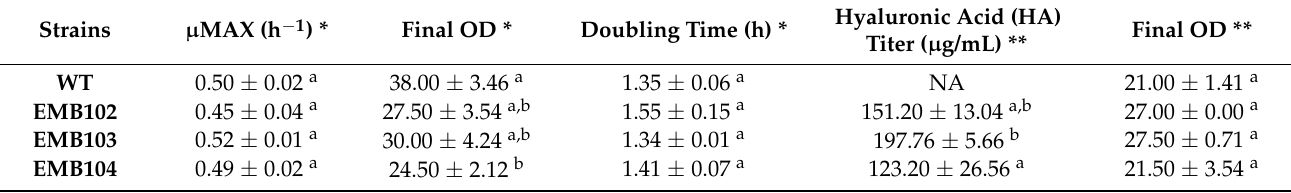
Table 2. The final OD 600 and maximum specific growth rates ( µ MAX) from wild type and EMB strains as well as the HA titer obtained by EMB strains when cultivated in shake flasks.